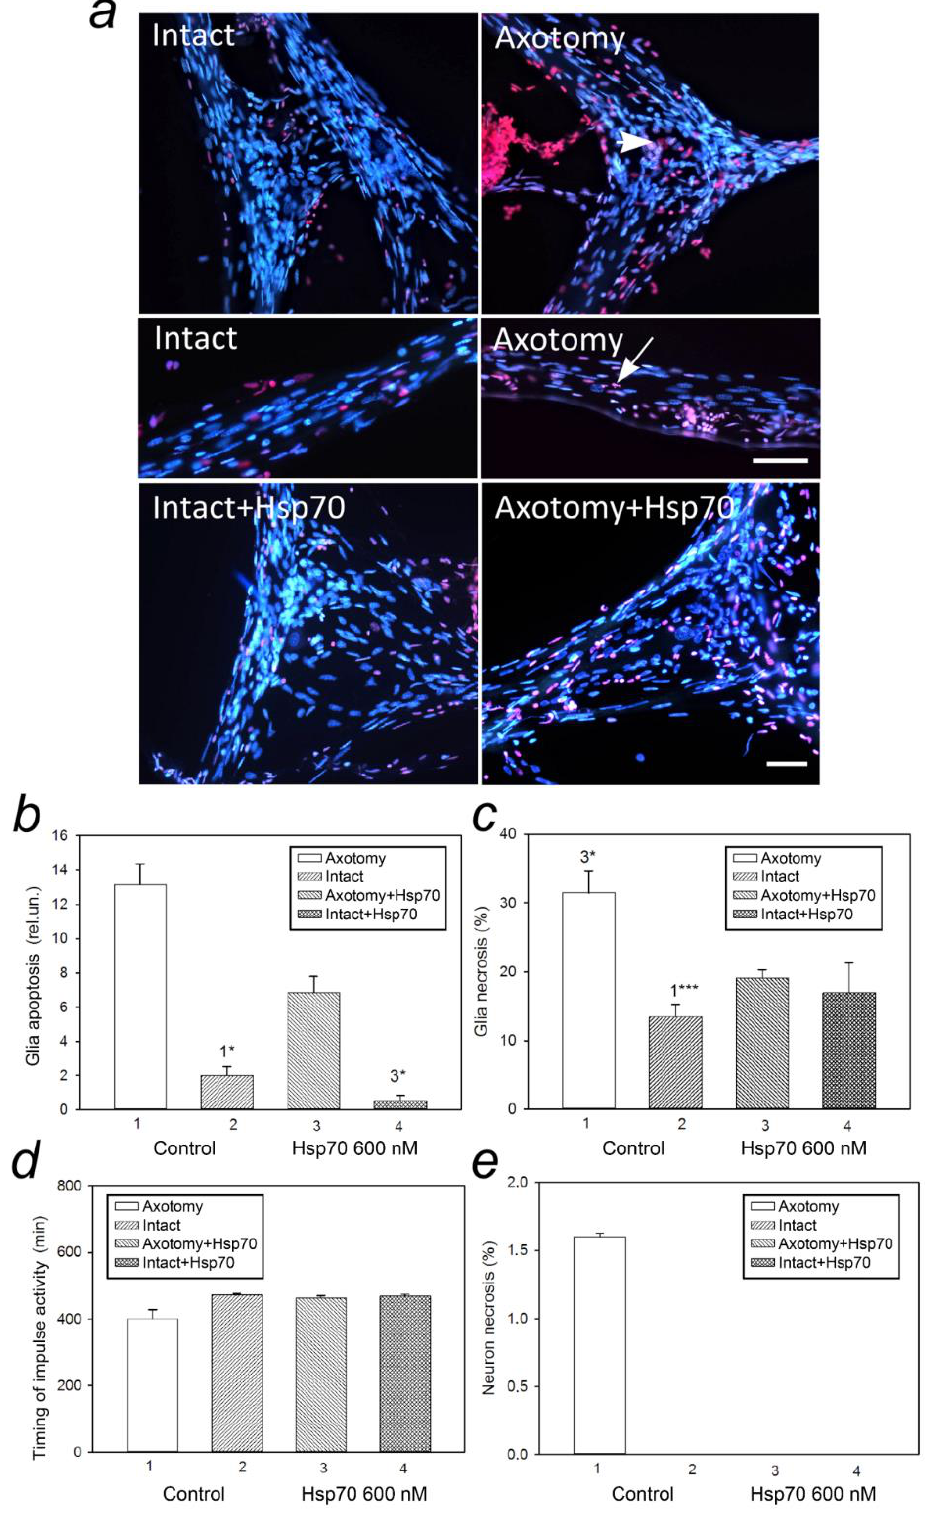
Figure 1. Effect of exogenous Hsp70 (600nM) on neuronal and glial cell death of the crayfish mechanoreceptor in normal conditions and after axotomy . ( a ) Immunofluorescence analysis of neuronal and glial cells after the addition of exogenous Hsp70 (600nM) to intact and axotomized crayfish MRN. Cell nuclei are stained with Hoechst 33342 (blue fluorescence indicates living or apoptotic cells) and propidium iodide (red fluorescence, allows for visualization of the necrotic cells). Arrows indicate the nuclei of the necrotic cells. Scale bar, 50 µm. N = 8. ( b ) Changes in the level of apoptosis of the glial cells in the crayfish mechanoreceptor in the area of the axon at 2 mm from the neuron body when exposed to exogenous Hsp70 (600 nM) in normal conditions, and after axotomy. The identification of apoptotic cells was based on characteristic morphological changes